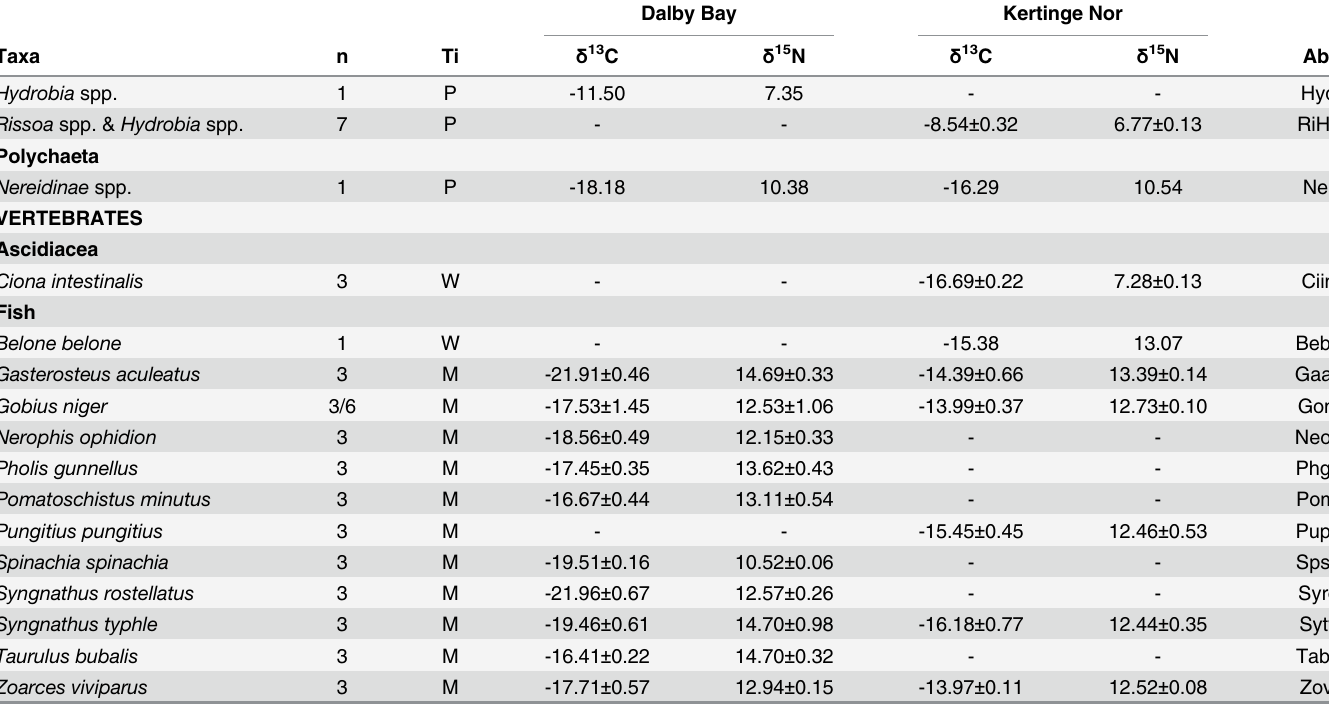
abbreviation. Identical abbreviations indicates sample values that have been pooled within site on Fig